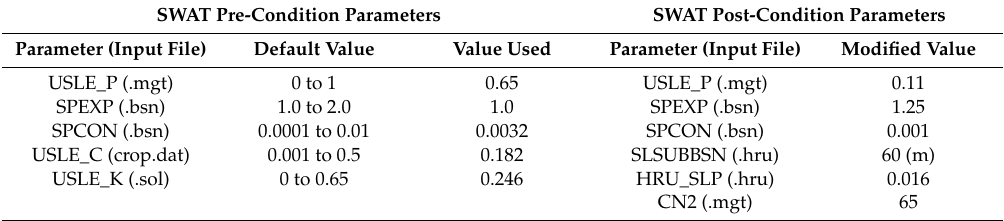
Table 2. Soil erosion parameters used during the model’s application without conservation structures (pre-condition) also used for Catchment-25 calibration. Post-condition parameters represent the conservation structures. SPEXP: exponential channel sediment routing factor; SPCON: linear channel sediment routing factor; USLE_C: conservation practice factor; USLE_K: soil erodibility factor; SLSUBBSN: the average slope length for the sub-basin; HRU_SLP: average slope steepness of the hydrological response unit (HRU) input tables; CN: curve number.